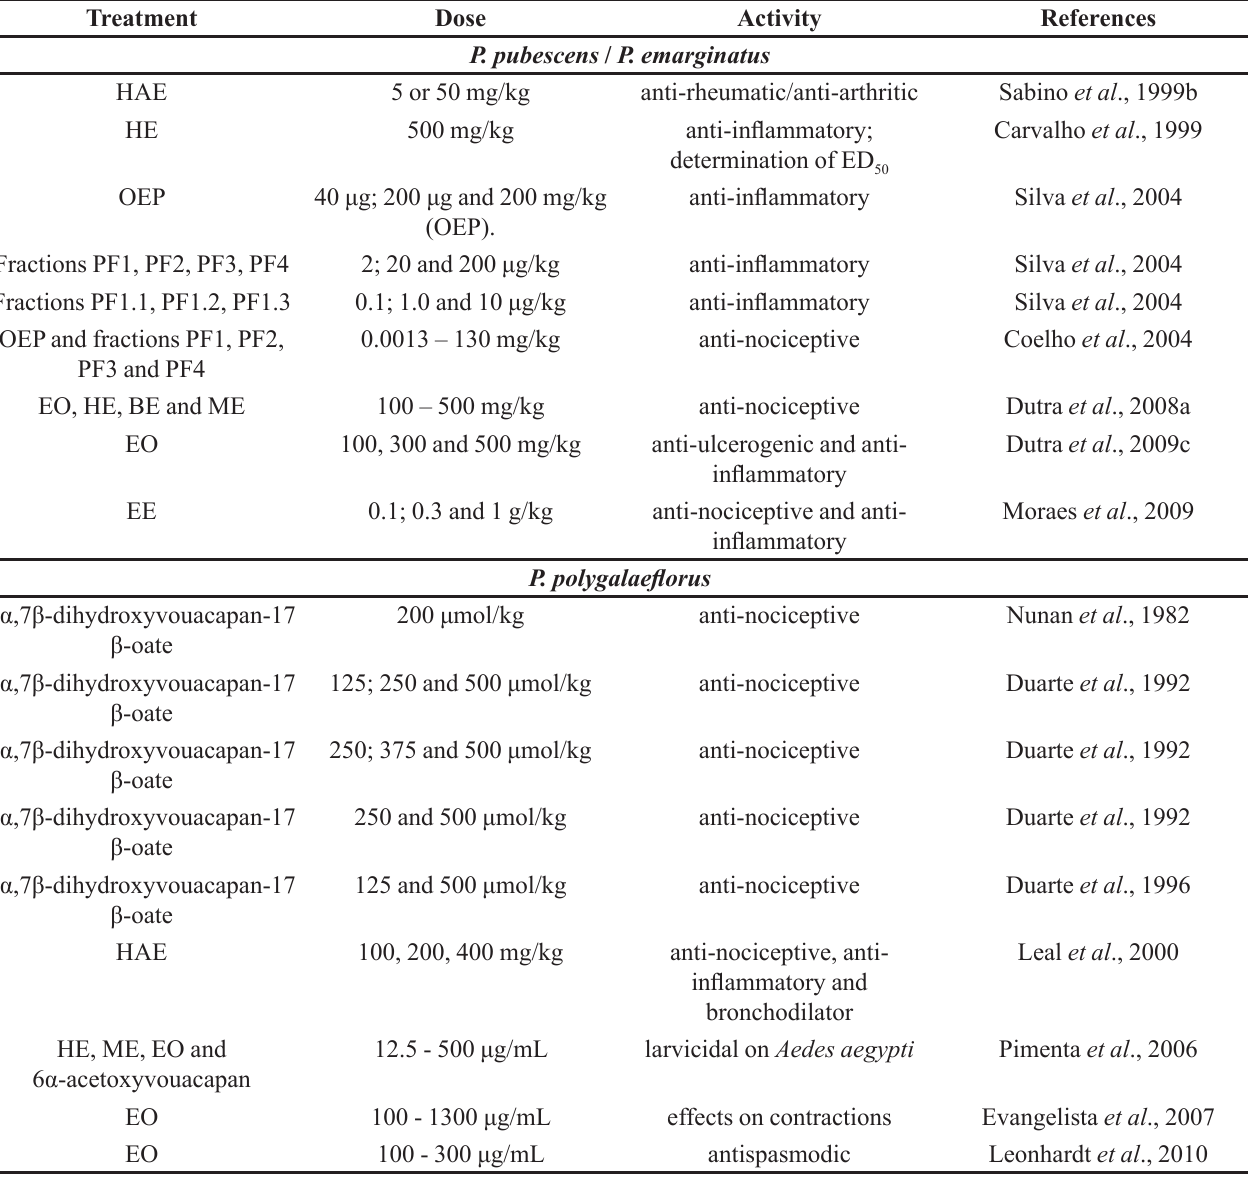
TABLE I - Biological activities in vivo of Pterodon spp . plant extracts/vouacapan derivative